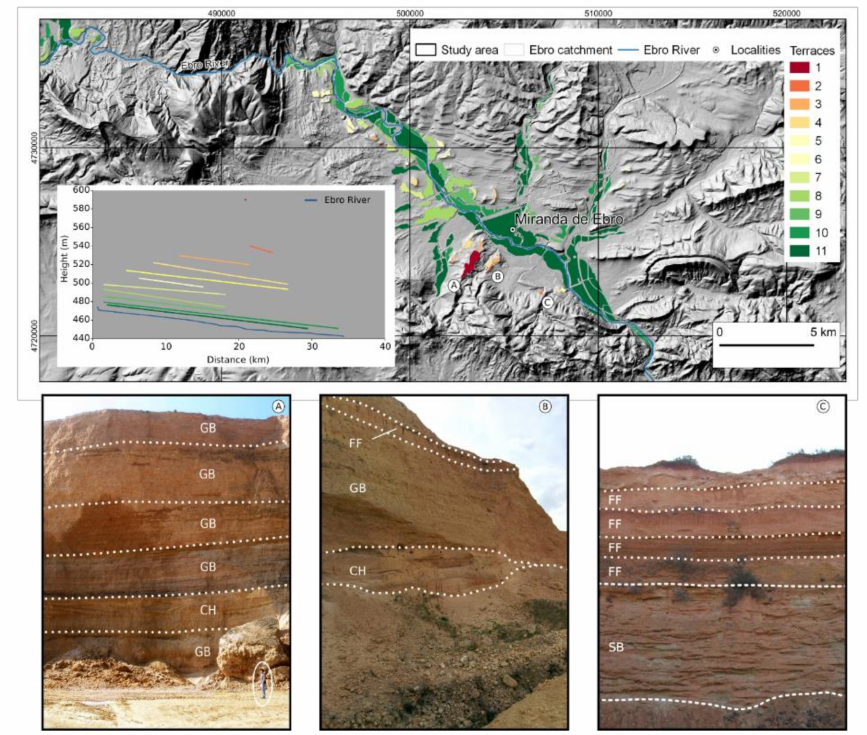
Figure 2. Map of terrace levels developed in Miranda Basin. Bottom left inset shows reconstructed river profile for each terrace level based on terrace surface points extracted from a 5 m resolution DEM (color range is the same as that used for terraces on the map; see legend). Below are field images of terrace deposits: A, Monte Miranda–Yarritu; B, Monte Miranda–Arinorsa; C Aer ó dromo. White capital letters refer to water laid deposits: channels (CH); gravel bars (GB); sandy bedforms (SB); floodplain fines